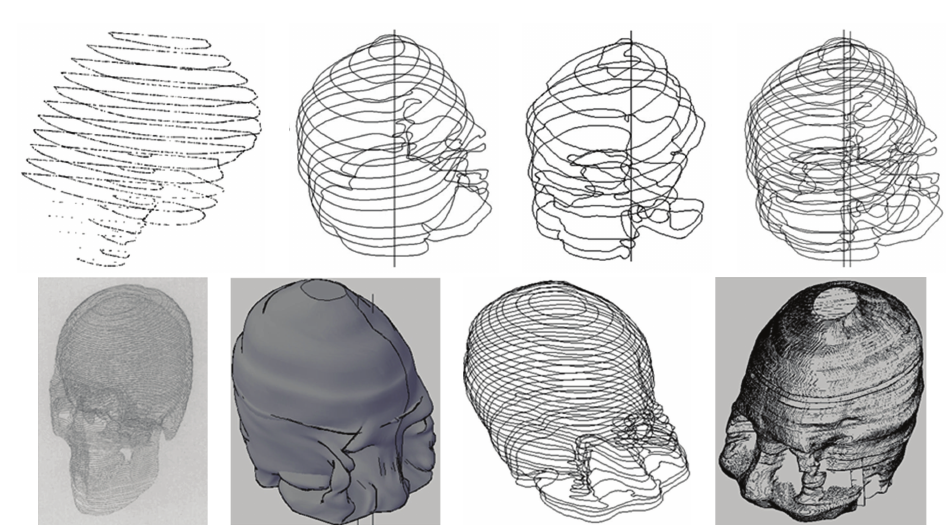
Figure 15: 3D space model of cranial cavity with